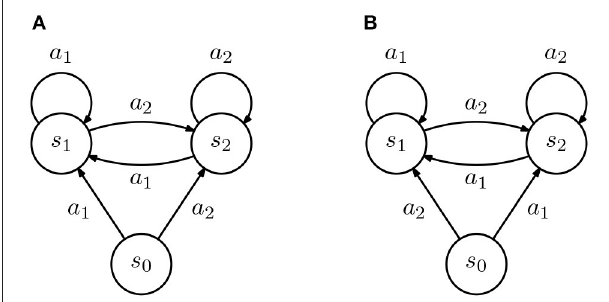
FIGURE 2 | Diagram representing two inverse reinforcement learning (IRL) agents (all transition are deterministic). (A,B) The two agents are similar in all states except s 0 , where actions a 1 and a 2 lead to different states.